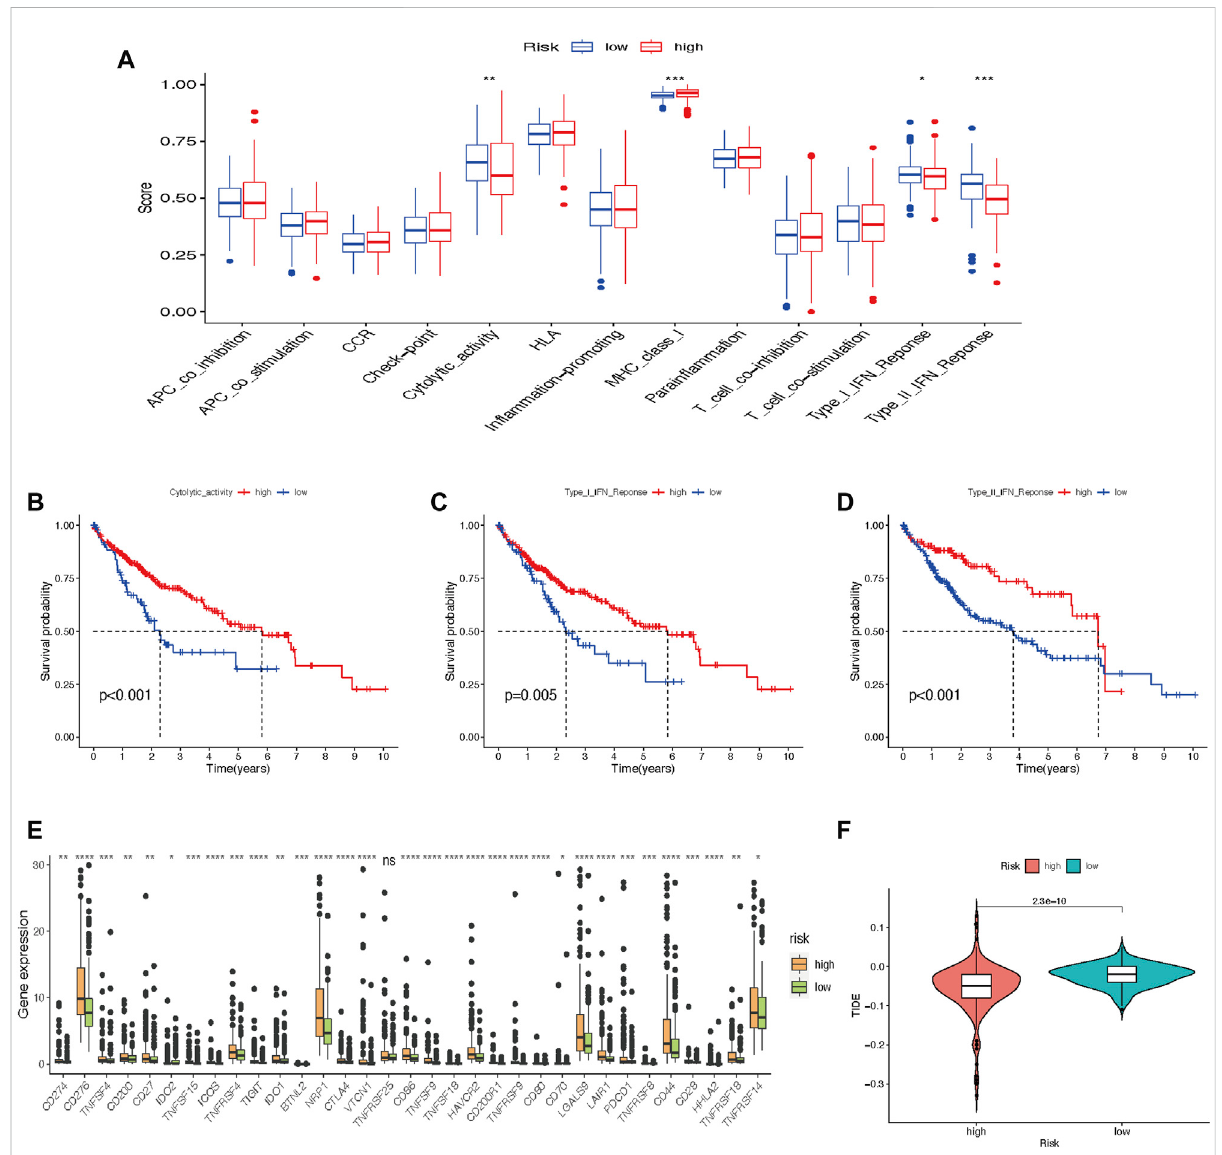
FIGURE 10 Tumor immune cell in fi ltration and gene expression. (A) Box plot of immunologic function analysis. (B – D) Relationship between cytolytic- activity, type-I-IFN-response, and type-II-IFN-response and survival of HCC patients in high- and low-risk groups. (E) Box plot of 33 immune checkpoints. (F) TIDE analysis shows different immune responses in high- and low-risk groups (* p < 0.05; ** p < 0.01; *** p < 0.001). HCC, hepatocellular carcinoma; TIDE, tumor immune dysfunction and